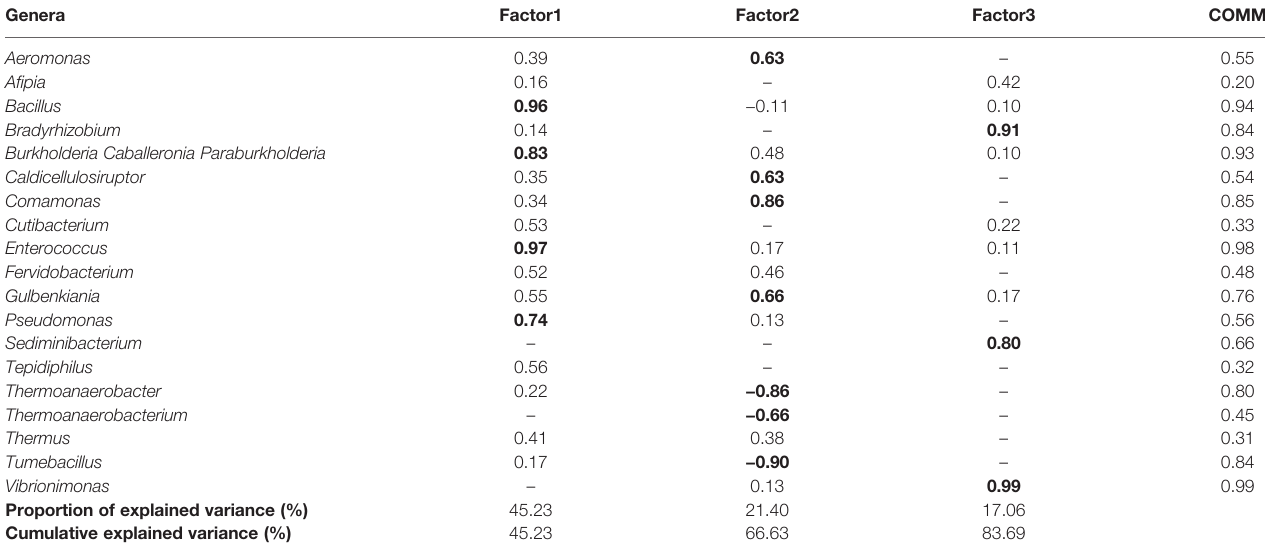
TABLE 3 | Factor-loading matrix * , commonalities (COMM), and explained variance for three microbiome patterns identi fi ed by factor analysis. Genera